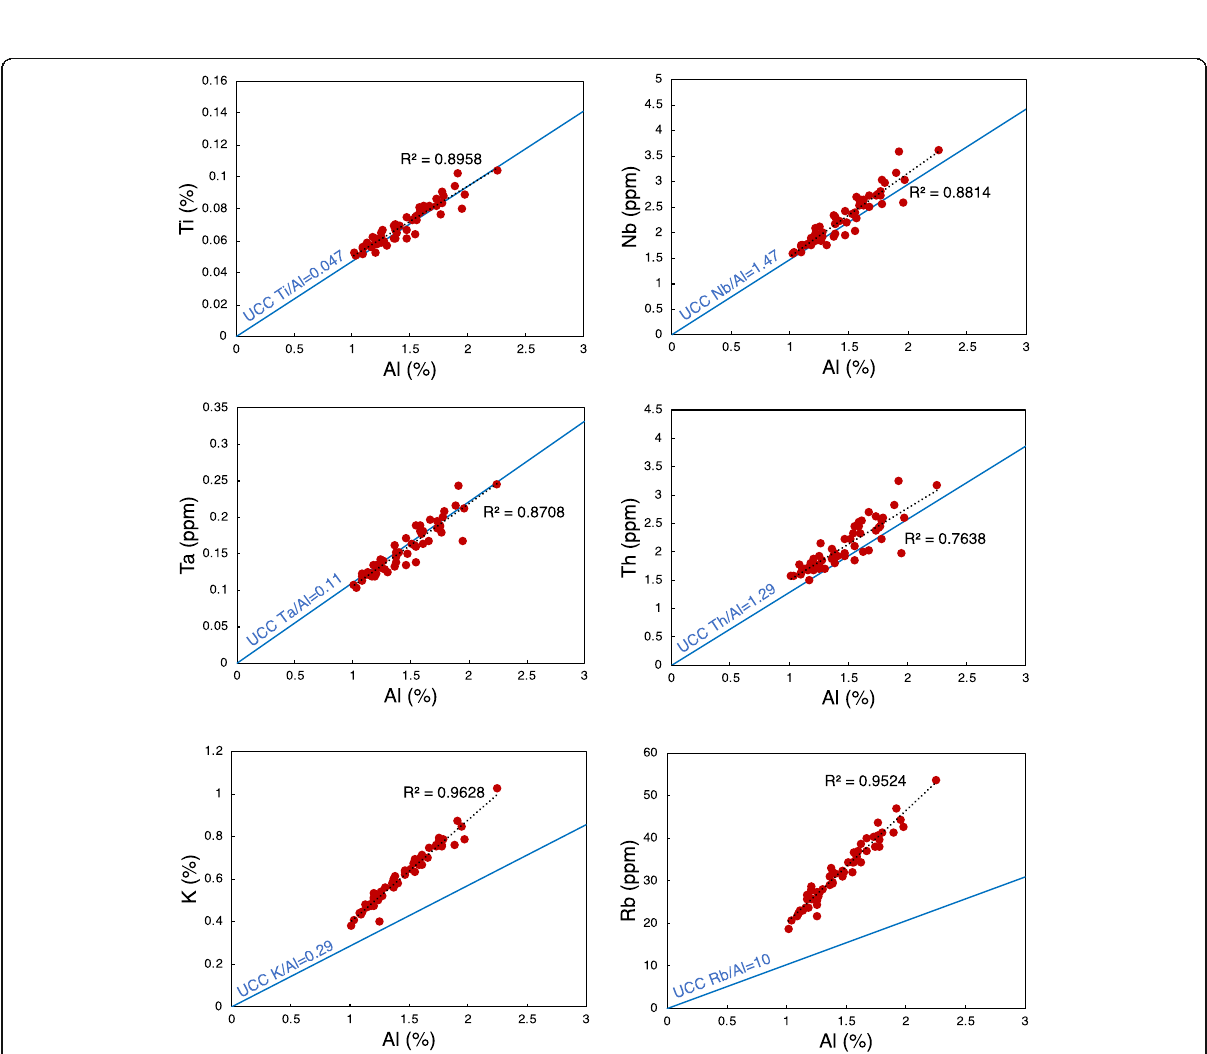
Fig. 5 Plots of Al vs. Ti, Nb, Ta, Th, K, and Rb for the chert samples. Ti/Al, Nb/Al, Ta/Al, and Th/Al ratios are identical to those of average UCC (Rudnick and Gao 2014), whereas K/Al and Rb/Al ratios are significantly higher than those of